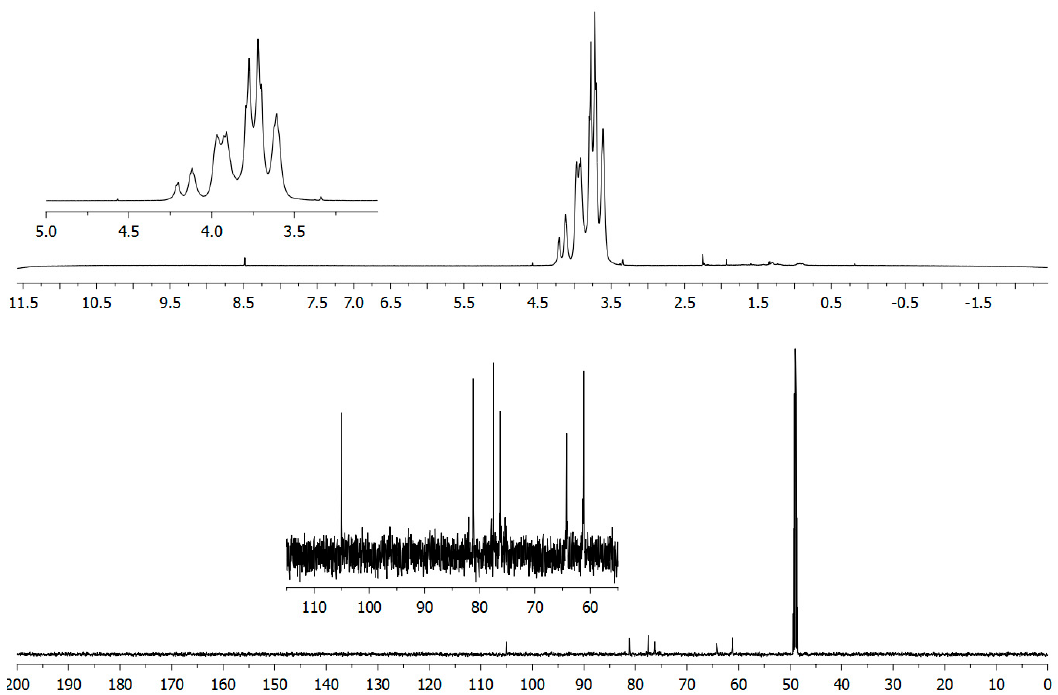
Figure 3. 1D-NMR analysis of the Lev_2ASCA polymer: 1 H (upper) and 13 C (lower) traces were recorded with a 600MHz Bruker spectrometer. The x-axis for each spectrum were in chemical shifts reported as parts per million (ppm) with reference to D 2 O and to CD 3 OD for 1 H and 13 C spectrum, respectively. Microorganisms 2020 , 8 , x FOR PEER REVIEW 11 of 16